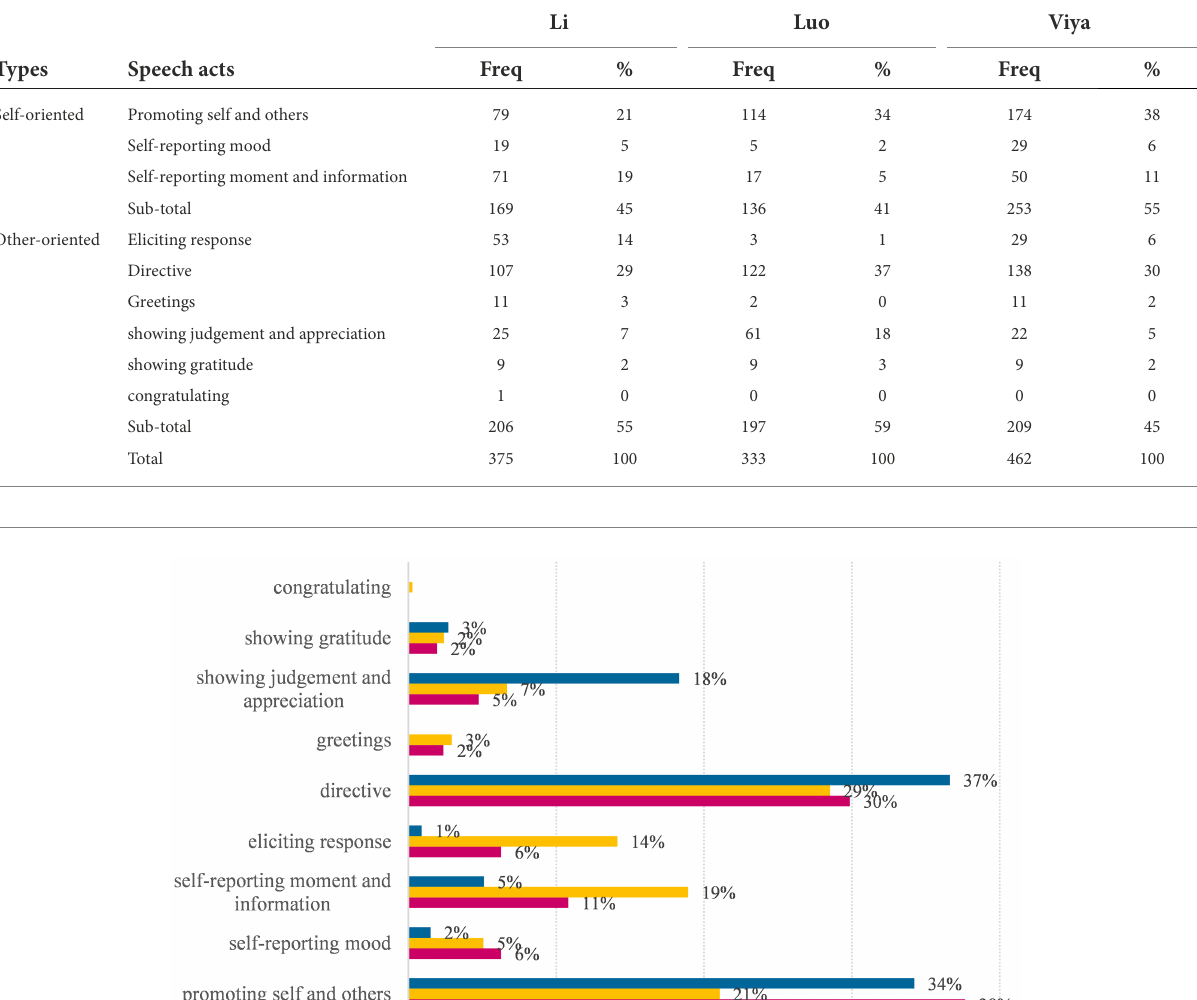
TABLE 5 Frequencies of speech acts.